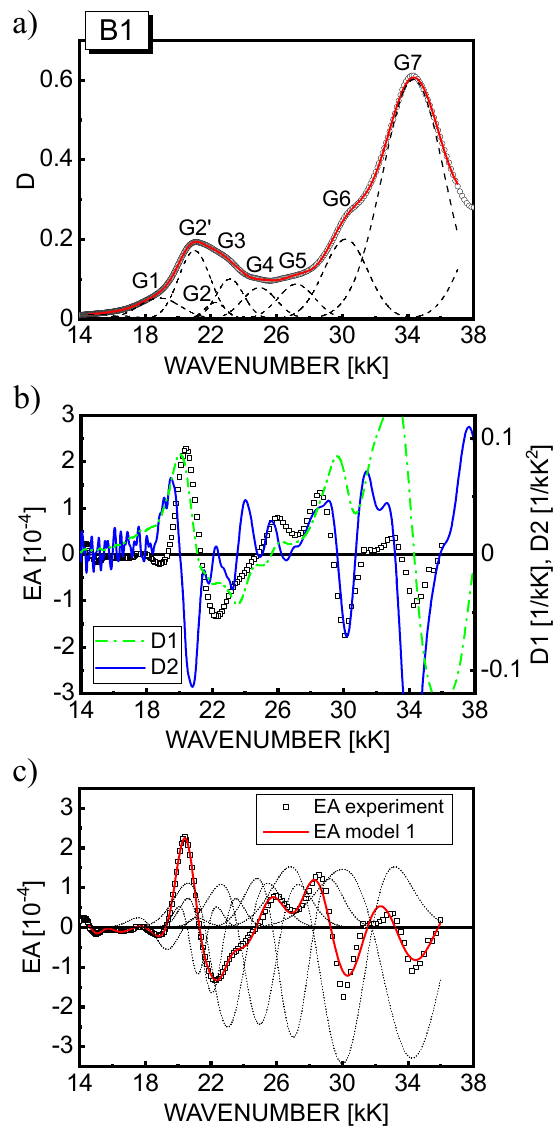
V/cm, compared with the calculated first (D1, dash − dotted line) and second (D2, solid line) deriva- tives of the absorption spectrum shown in part (a) of the figure. The values of all signals were mul- tiplied by a factor of 2.5 in the lower − energy range indicated by the dashed vertical line; ( c ) The best fit of experimental EA data for RuLp(PF 6 ) 2 (squares) with the theoretical curve calculated according to model 1 (solid line). The dotted lines represent the second derivative contributions from the cor- responding Gaussian profiles.